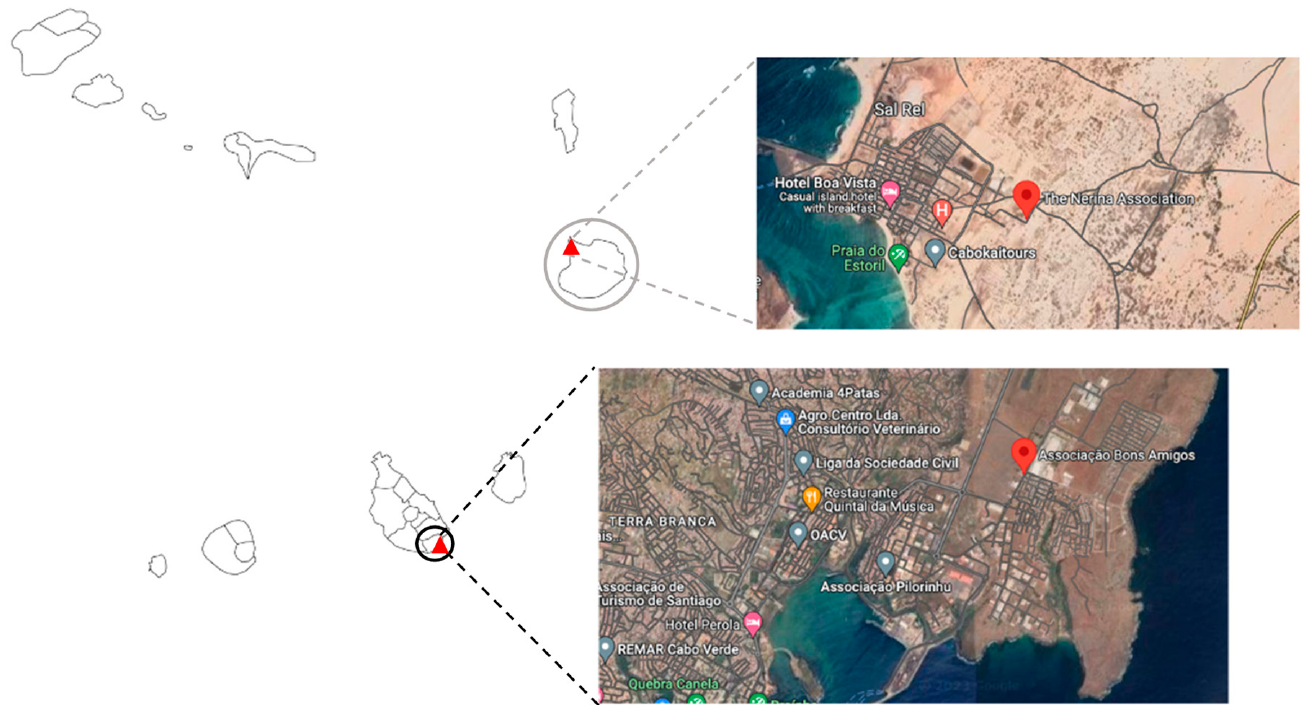
Figure 1. Map of Cape Verde and study area. The municipality of Praia is marked with a black circle, and Bons Amigos Association (Bons Amigos) with a red pin. The municipality of Boa Vista is marked with a grey circle, and Nerina Association (Nerina) with a red pin. The map was adapted from Vemaps © (vemaps.com) and Google Maps (maps.google.com).